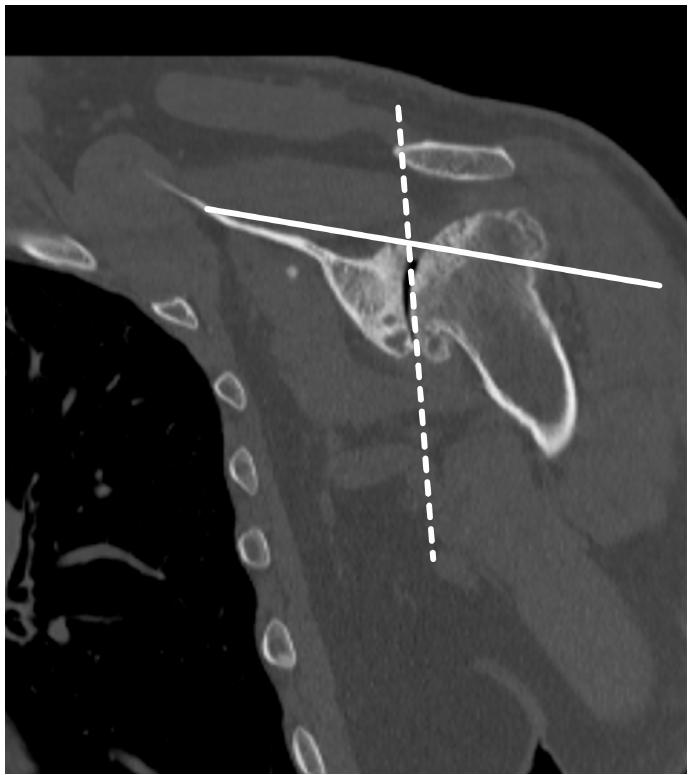
Figure 9. Coronal CT image showing glenoid inclination measurement. The inclination angle is measured between a line drawn along the supraspinatus fossa (solid line) and a second line along the glenoid fossa (dotted line).